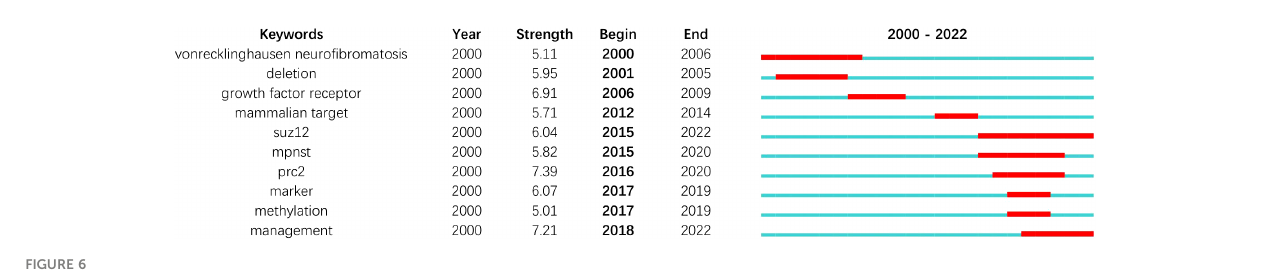
FIGURE 6 Citation bursts for the top 10